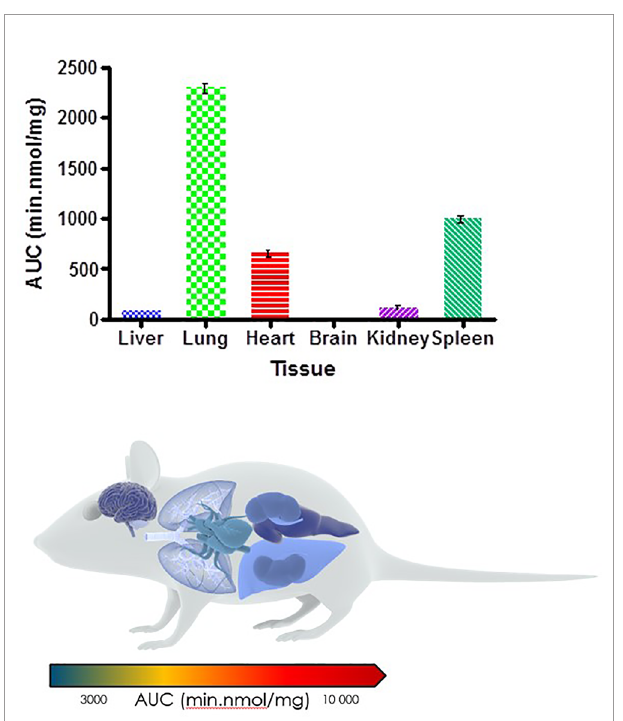
FIGURE 5 | Total drug exposure (AUC) in organs after oral administration of RMB041 (n = 3 per time-point; data presented as means ± SD).